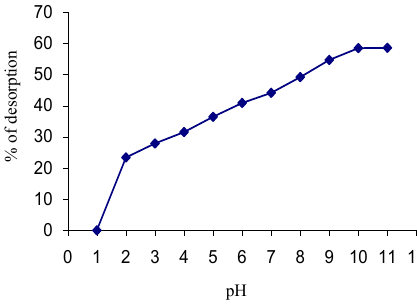
Figure 15 . Percentage of desorption of AG 25 from